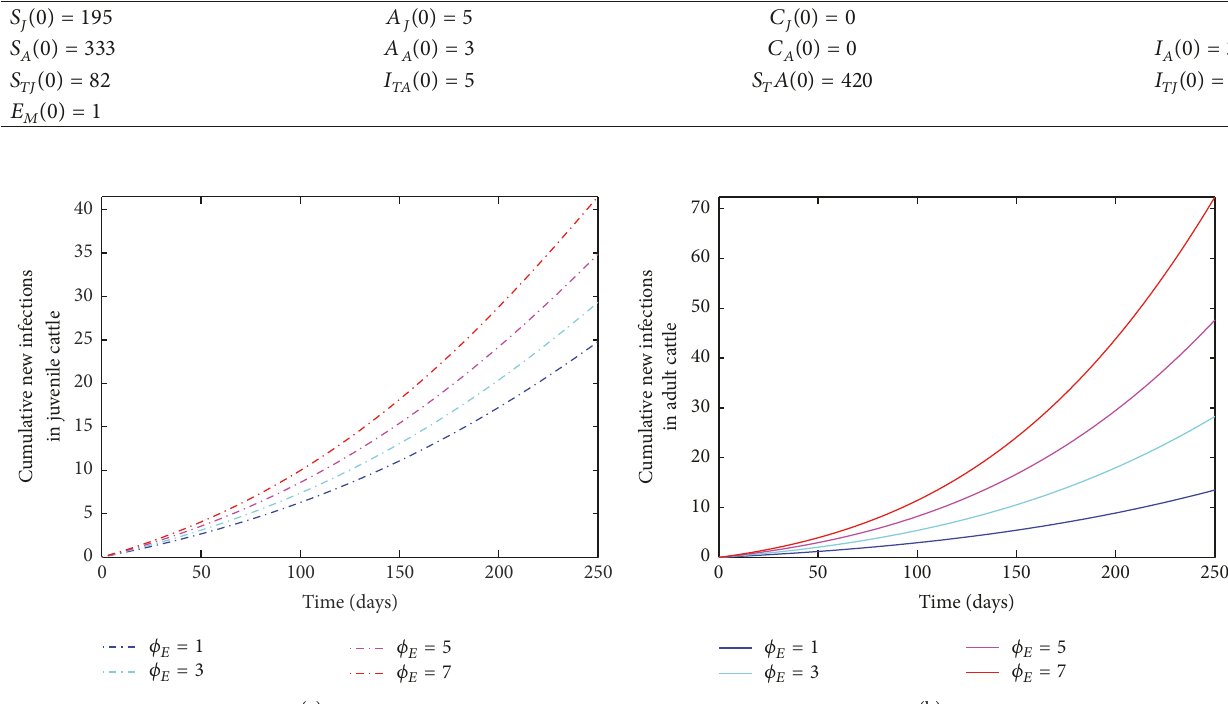
Figure 4: Simulation of the bovine anaplasmosis model (12) as a function of time while varying 𝜙 𝐸 . (a) Cumulative new infections in juvenile cattle; (b) cumulative new infections in adult